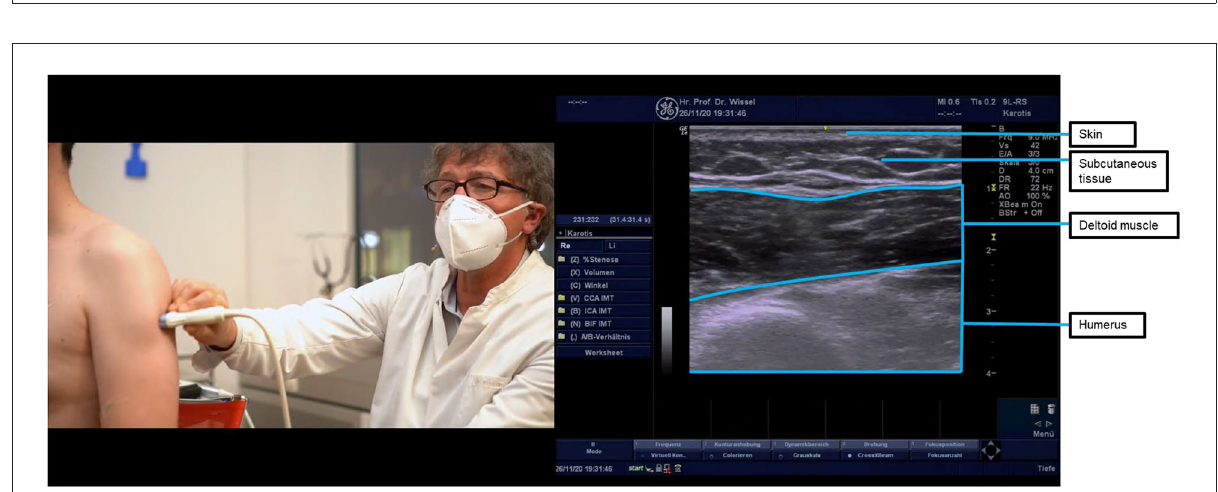
FIGURE2 Ultrasound probe placement and image of the intermediate deltoid (pars acromialis) muscle. The deltoid has a monomorphic appearance with stripes, when the ultrasound probe is placed longitudinally, and dots with facias/tendon-like structures, when the probe is transversally orientated. The injection target to treat retroversion and extension is the posterior part of the deltoid muscle. In the figure, the probe is compressing the arm to show the deltoid muscle at the top and humerus muscle at the bottom of the ultrasound image. To visualize and inject the anterior deltoid, the probe should be slid anteriorly from the position shown; to visualize and inject the posterior deltoid, the probe should be slid